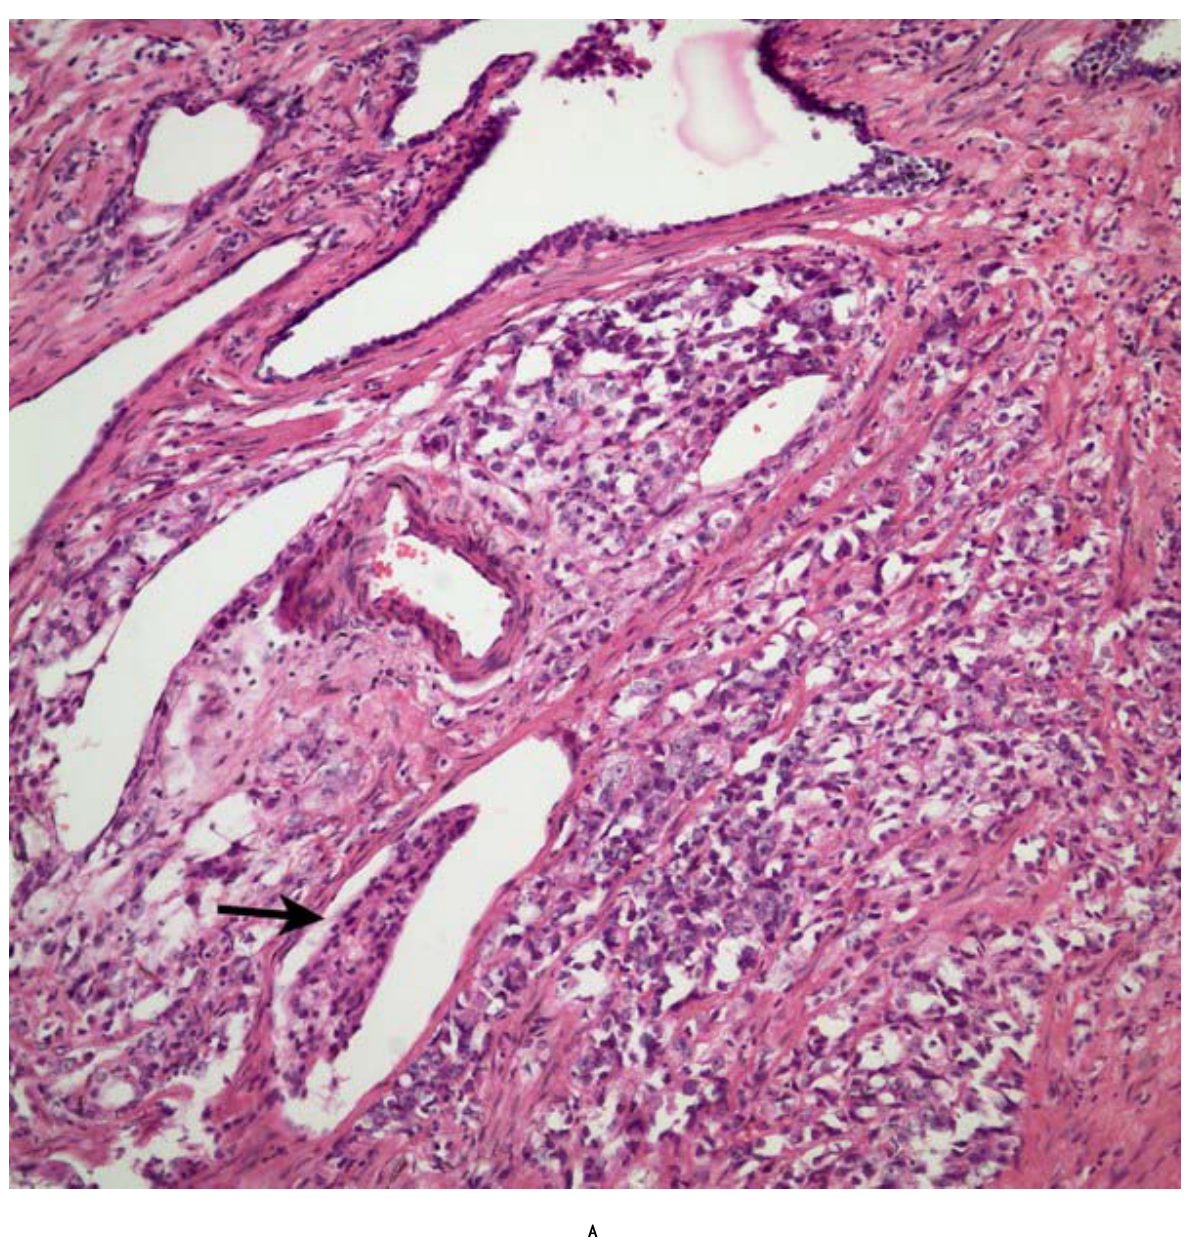
FIGURE 1. Intravascular neoplastic cells. (A) Inside the tumor (H-E × 400); (B) at the periphery of the tumor (H-E × 200); (C) distant from the tumor (H-E × 400).